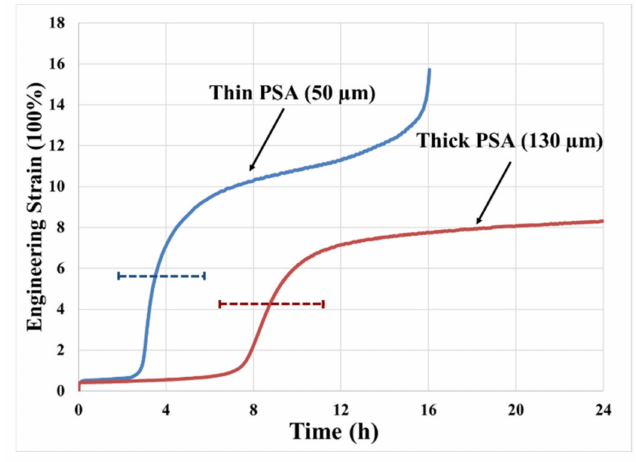
Figure 5. Creep response of thin vs. thick PSA under loading conditions of 50 kPa and 70 ◦ C.